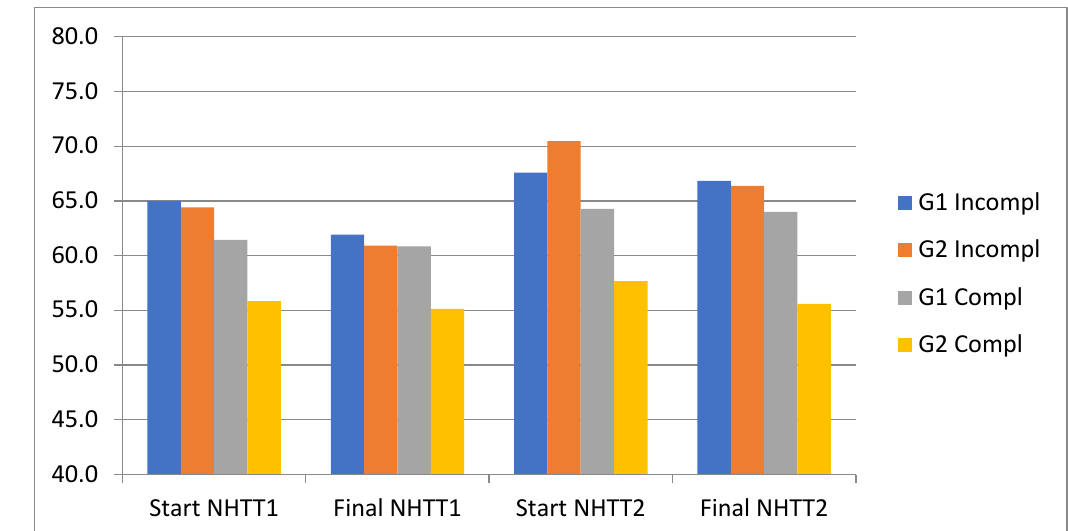
Figure 5. Evolution of SmO 2 (%) in both test and subgroups. NHTT1: first normobaric hypoxia tolerance test; NHTT2: second normobaric hypoxia tolerance test; G1 incompl: group of parachutists with incomplete test; G2 Incompl: group of students with incomplete test; G1 Compl: group of par ‐ achutists with complete test; G2 Compl: group of students with complete test.